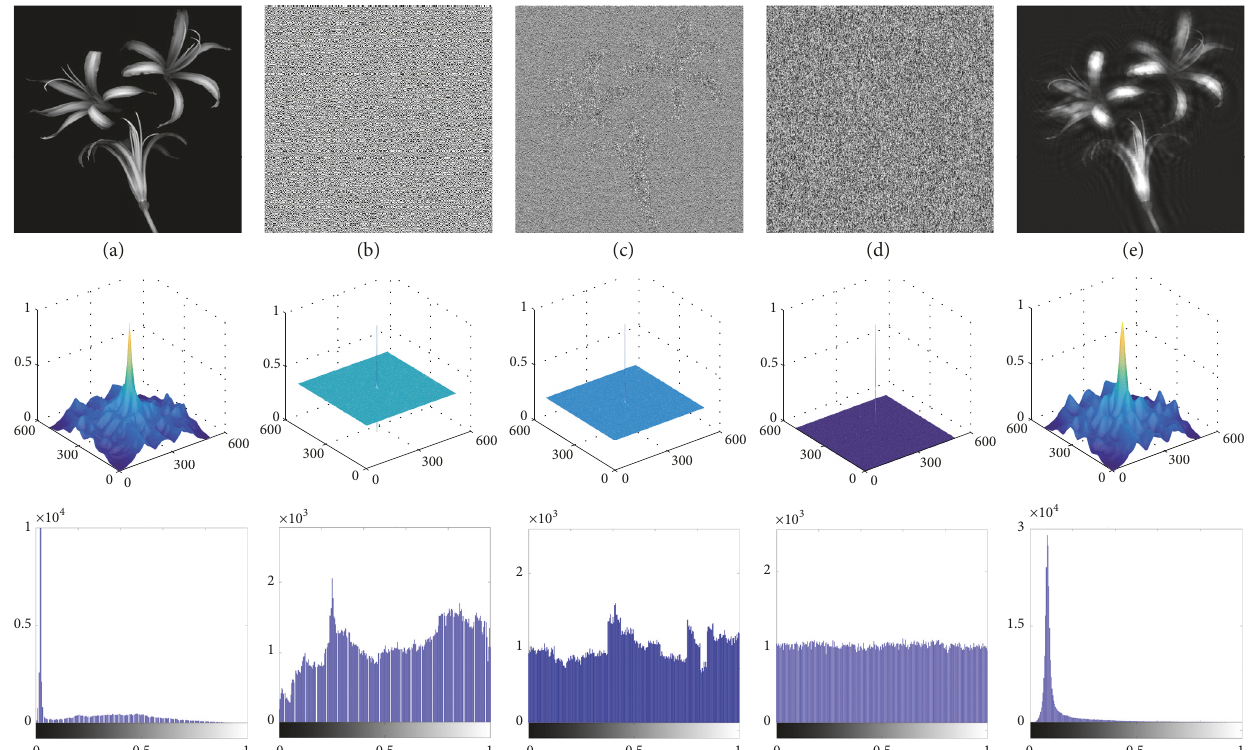
Figure 3: Simulation of proposed method: (a) the original image, (b) 2D-SLMM, (c) 1st round XOR encrypted image, (d) 2nd round XOR encrypted image, and (e) decrypted image. The second row shows their corresponding autocorrelation images and the third row shows their corresponding